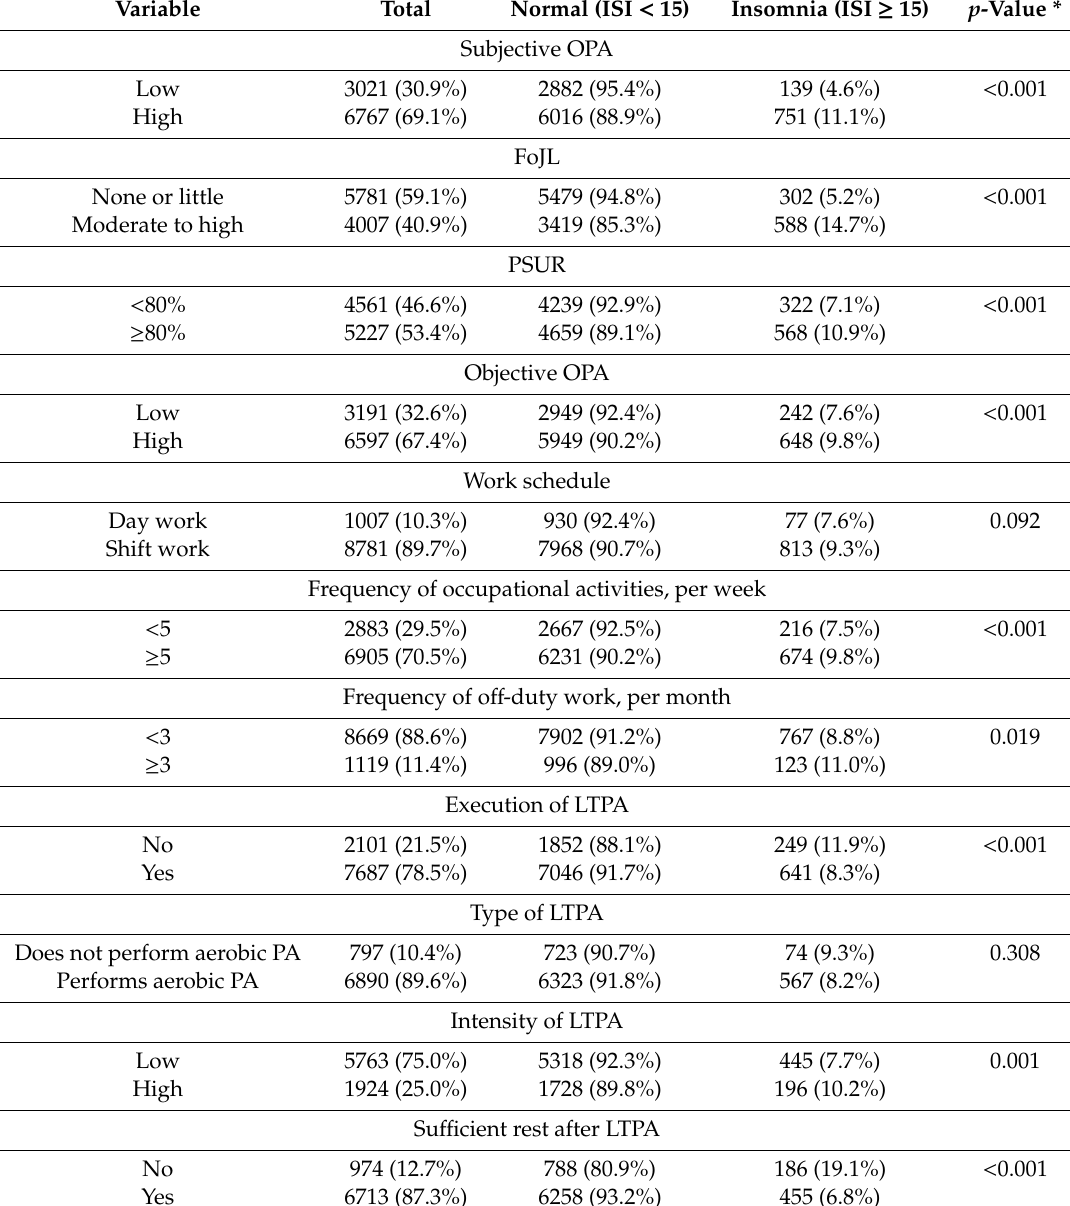
Table 2. Occupational physical activity (OPA), and leisure-time physical activity (LTPA)-related characteristics of the study